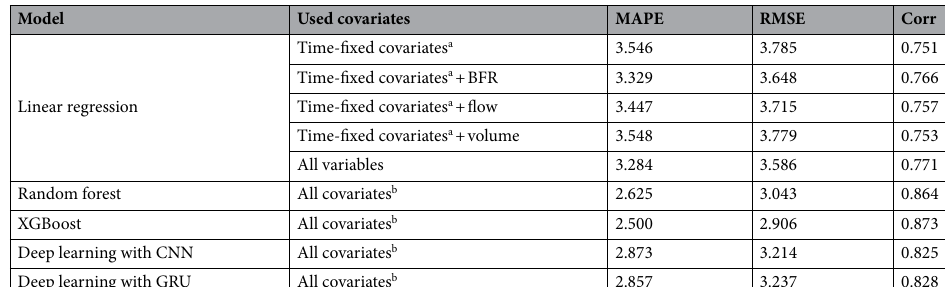
Table 2. A performance measurement summary for URR prediction models. URR urea reduction ratio, MAPE mean absolute percentage error, RMSE root mean square error, Corr Spearman’s rank correlation